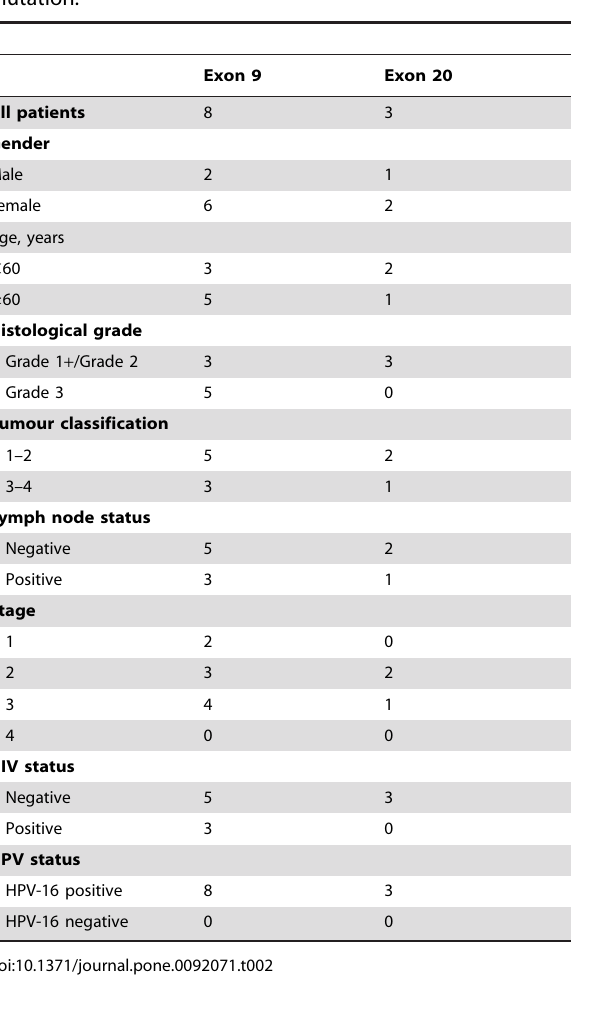
Table 2. Clinical characteristics of the patients with PIK3CA mutation.